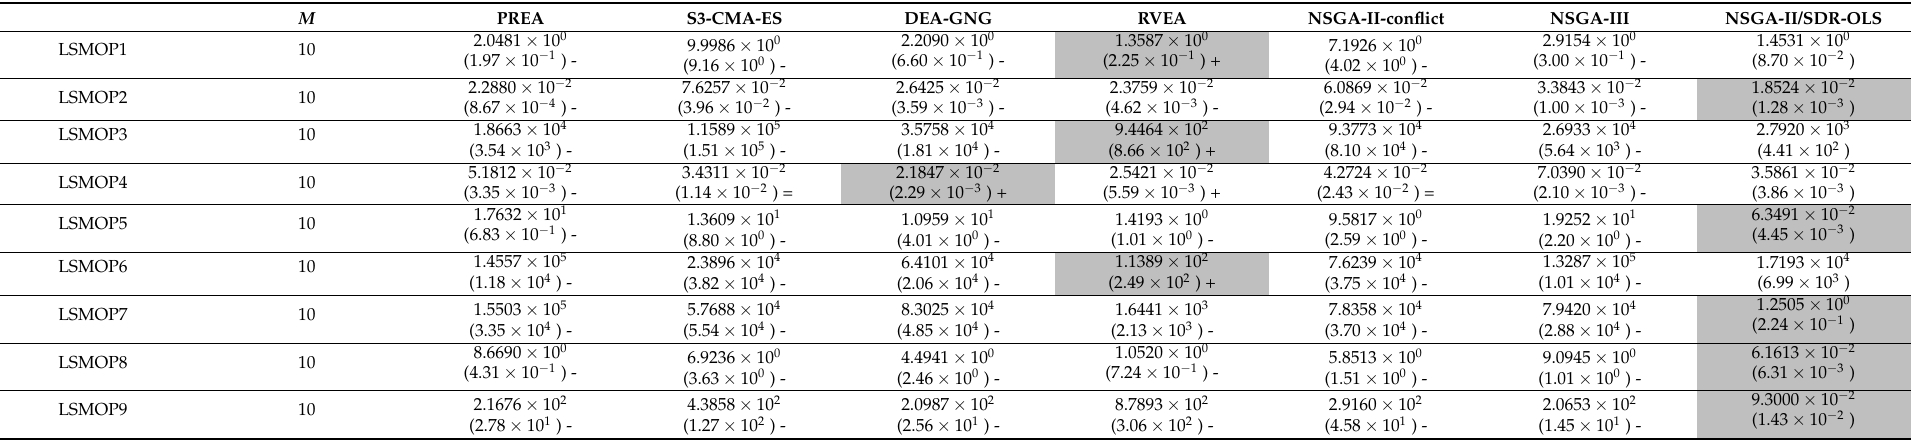
The gray background represents that this algorithm has the best performance on this problem. The number in the brackets represents the standard deviation, and the number out of the brackets represents the mean values. “+/-/=” means that the relevant algorithm performs better than/worse than/as well as the NSGA-II/SDR-OLS algorithm. Same below table. Table 13. GD values for 9 ten-objective benchmark